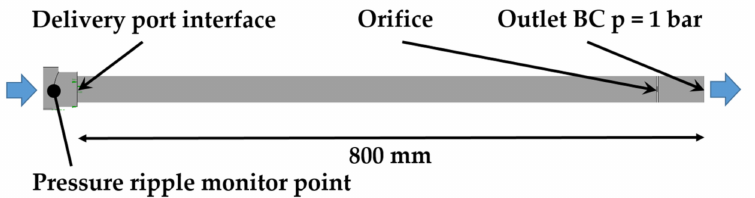
Figure 11. Tubular extension of the computational domain at the delivery port to investigate the outlet pressure ripple of the pumps in the CFD